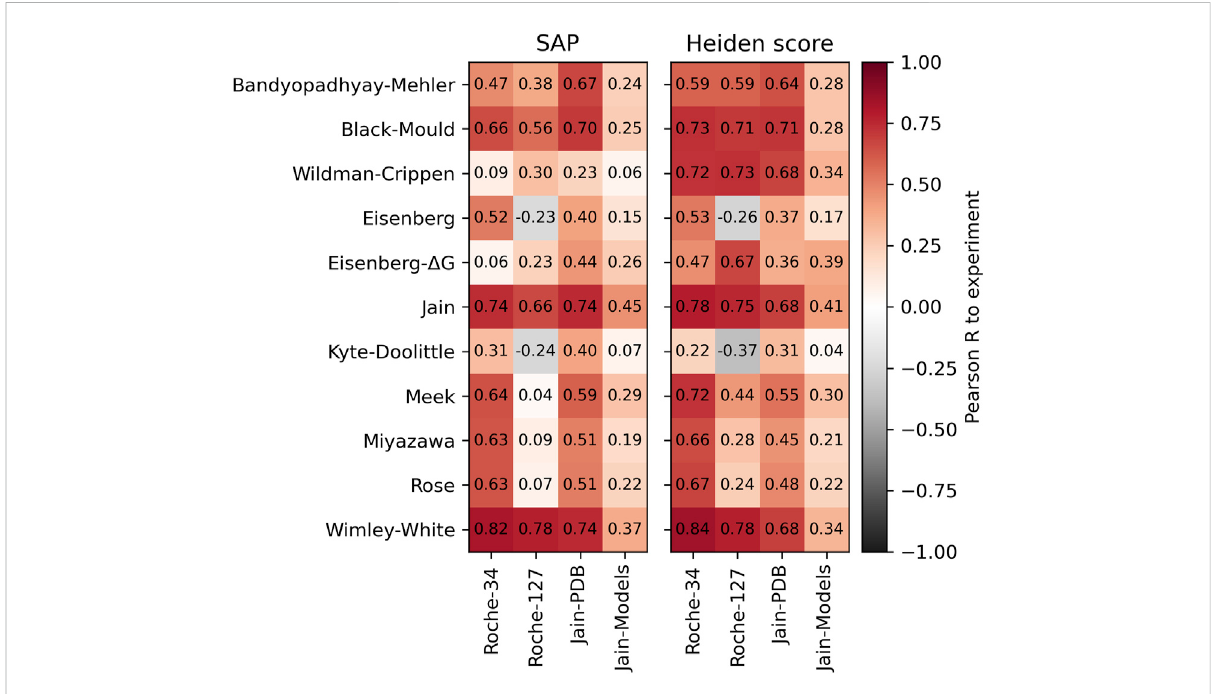
FIGURE 3 Performance of the SAP method (left) and the Heiden method (right) with different hydrophobicity scales. The Pearson correlation was calculated with respect to the HIC retention times of the respective